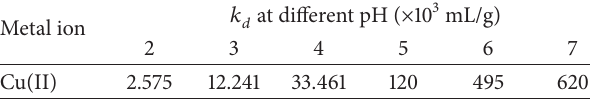
Table 1: Distribution coefficient, 𝑘 𝑑 , of Cu(II) ions adsorption by magnetic nanocomposite. Metal ion